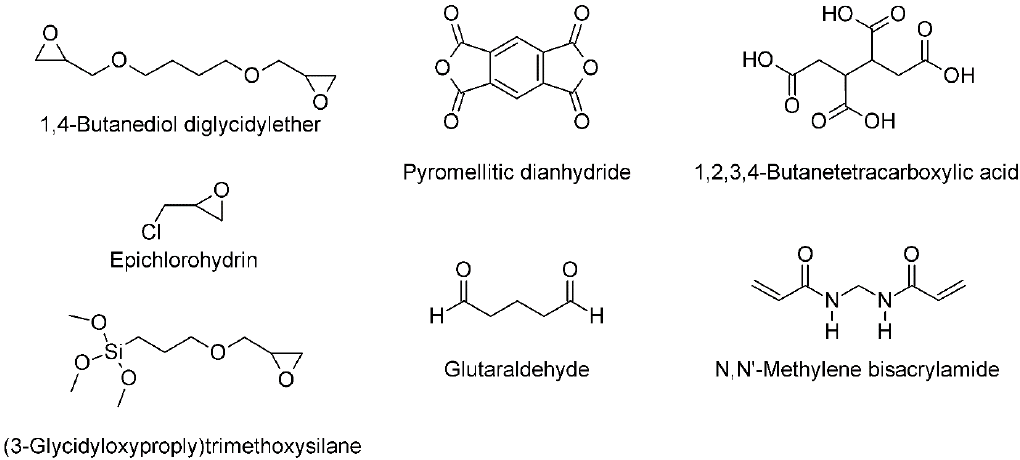
Figure 3. Typical molecules for cellulose